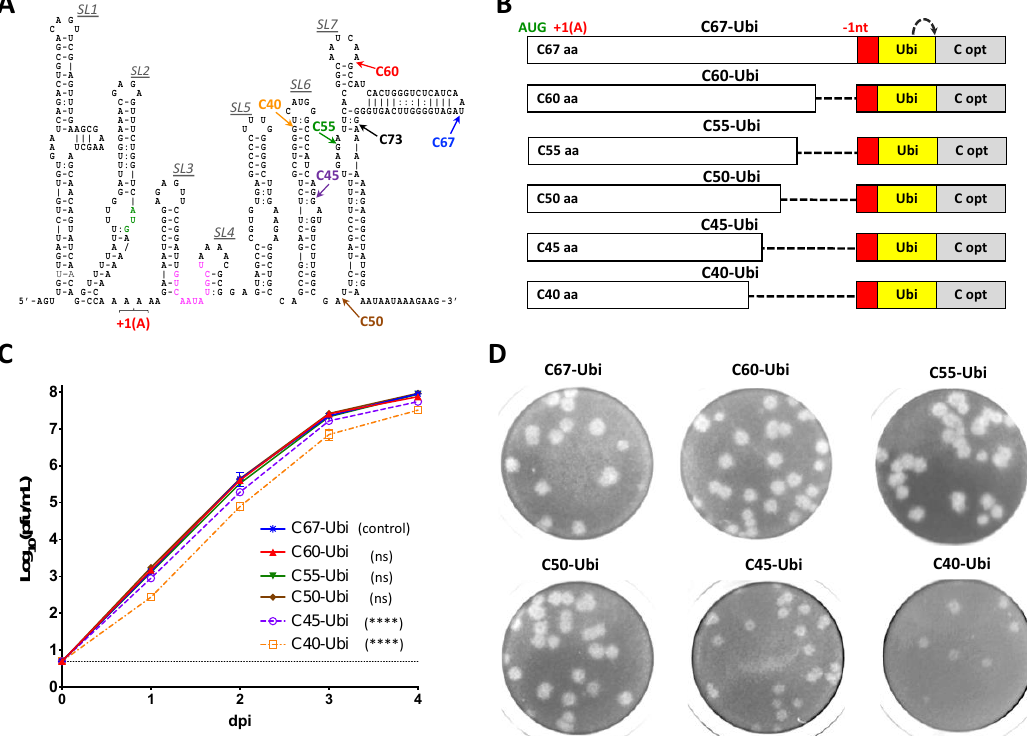
Figure 2. Identification of a minimal region of C gene that is required for ZIKV growth in Vero cells by deletional analysis. ( A ) Predicted stem-loop structure of the 5 (cid:48) -end of ZIKV genome (strain Paraiba_01 / 2015). Colored arrows indicate codon positions at which 5 (cid:48) terminus of wt C gene sequences were fused with target sequence for mir-124 (red box in panel B). Sequence highlighted in green indicates translation initiation codon AUG of ZIKV polyprotein. Sequence highlighted in magenta indicates 5 (cid:48) genome cyclization sequence. + 1 (A) shows the position of ORF-shifting insertion ( + 1 nt) of a single A residue. ( B ) Schematic representation of viral genomes featuring gradual reduction of the wt C gene sequence from the 3 (cid:48) -end. Red and yellow boxes indicate target for mir-124-3p and ubiquitin gene, respectively. Gray boxes (C opt) represent full-length sequences of C gene that were mutated by synonymous substitutions. ( + 1 A) and (-1nt) are positions of ORF shifting and ORF restoring sequence modifications, respectively. Dotted arrow represents the site of cleavage by ubiquitin. ( C ) Growth kinetics of viruses in Vero cells after plasmid DNA transfection. Di ff erences between growth kinetics of C67-Ubi (mean virus titers for dpi 1–4) and those of the other five viruses depicted in panel B were compared using two-way ANOVA (**** p < 0.0001; ns—denotes not significant, p > 0.05). Dotted line represents limit of virus detection (0.7 log 10 pfu / mL). ( D ) Plaque morphology of viruses in Vero cell monolayer. Infected cells in 24-well plates were fixed at 5 dpi, and viral plaques were visualized by crystal violet